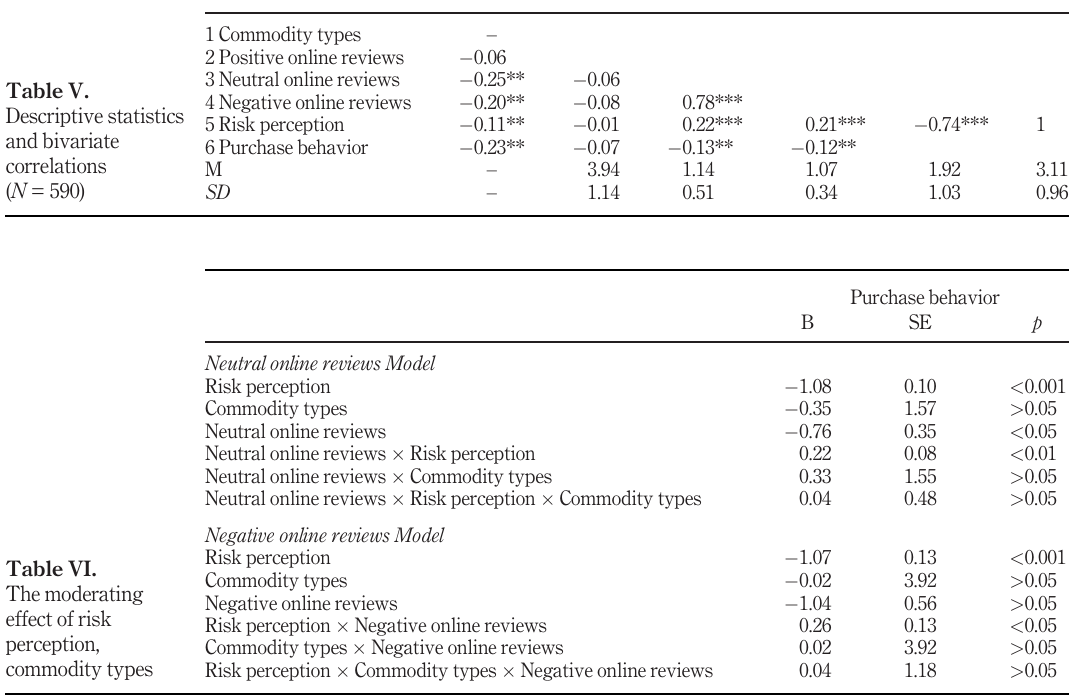
effect of risk perception, commodity